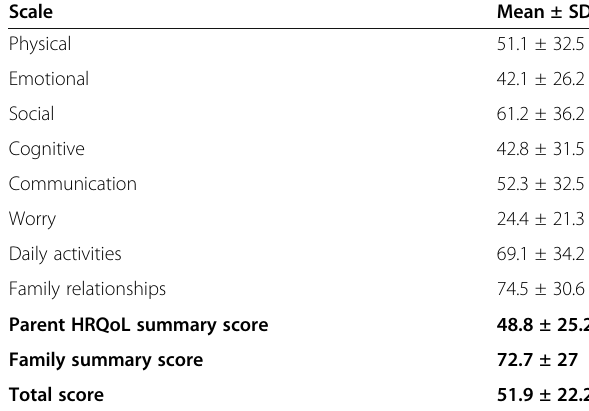
Table 3 PedsQL ™ Family Impact Score in caregivers of